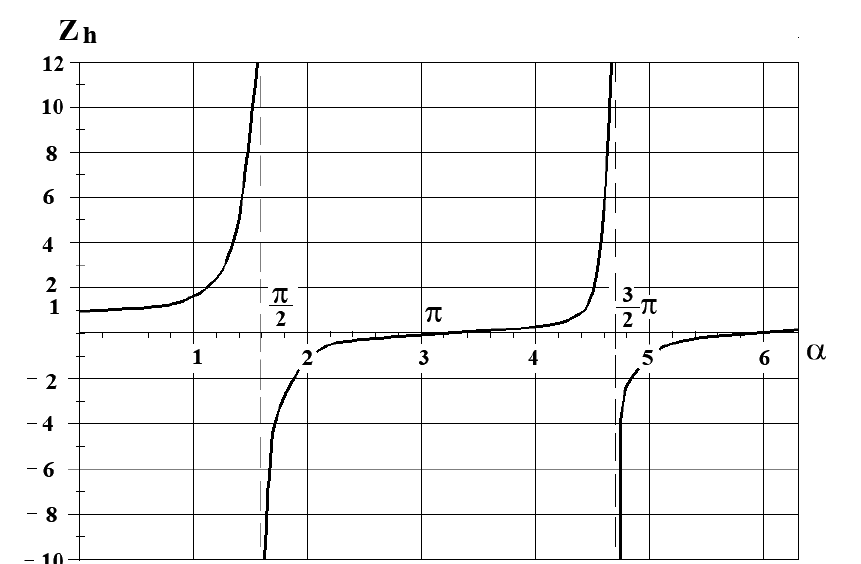
Fig. 1. Change of the function Z h depending on the dimensionless parameter